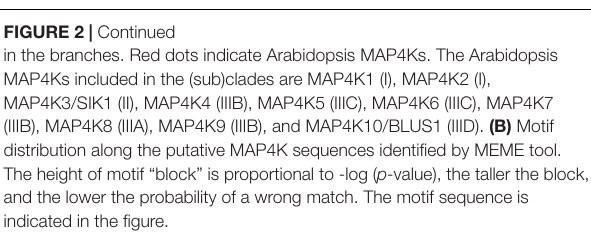
FIGURE 2 | Continued in the branches. Red dots indicate Arabidopsis MAP4Ks. The Arabidopsis MAP4Ks included in the (sub)clades are MAP4K1 (I), MAP4K2 (I), MAP4K3/SIK1 (II), MAP4K4 (IIIB), MAP4K5 (IIIC), MAP4K6 (IIIC), MAP4K7 (IIIB), MAP4K8 (IIIA), MAP4K9 (IIIB), and MAP4K10/BLUS1 (IIID). (B) Motif distribution along the putative MAP4K sequences identified by MEME tool. The height of motif “block” is proportional to -log ( p -value), the taller the block, and the lower the probability of a wrong match. The motif sequence is indicated in the